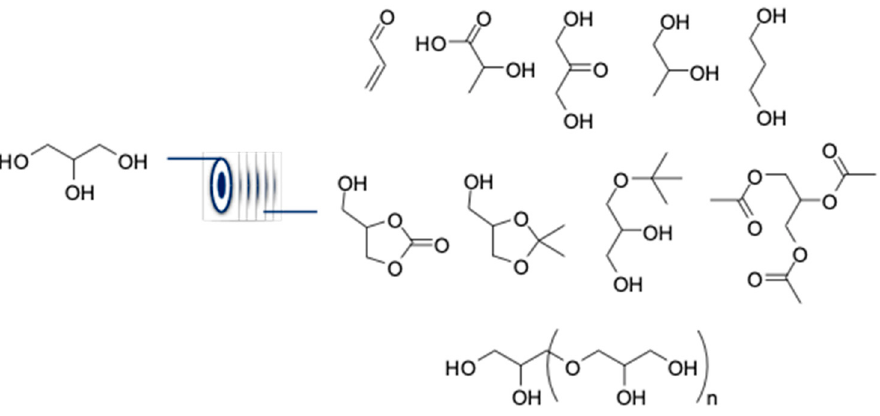
Figure 17. Roadmap of selected glycerol valorization reactions in continuous flow.